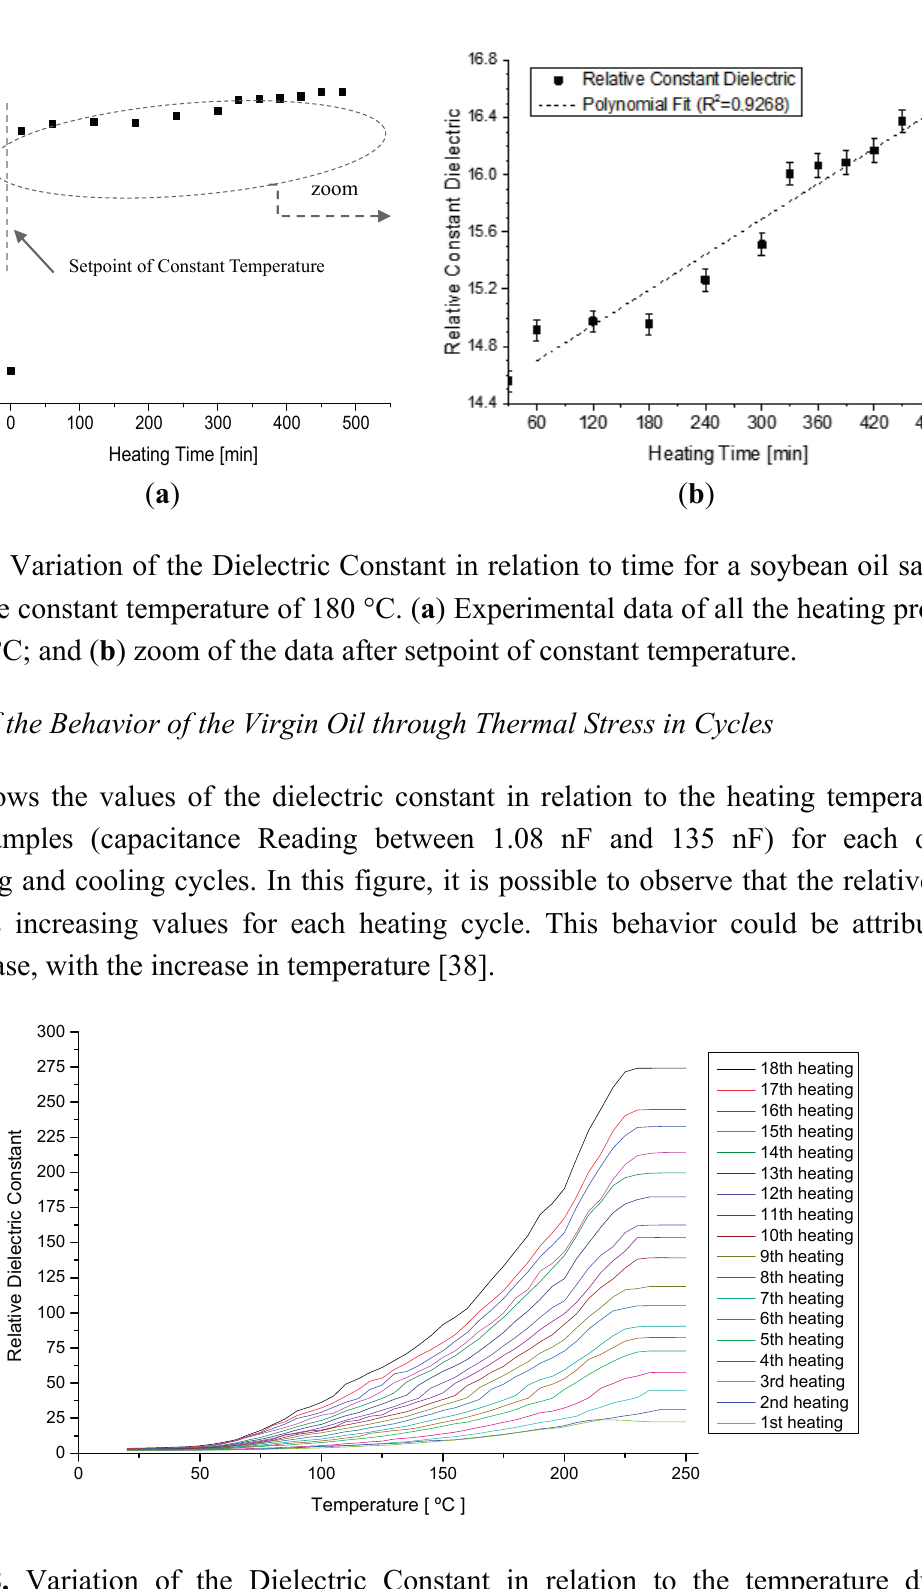
Figura 8. Variation of the Dielectric Constant in relation to the temperature during eighteen heating cycles of a sample of soybean oil (20 to 250